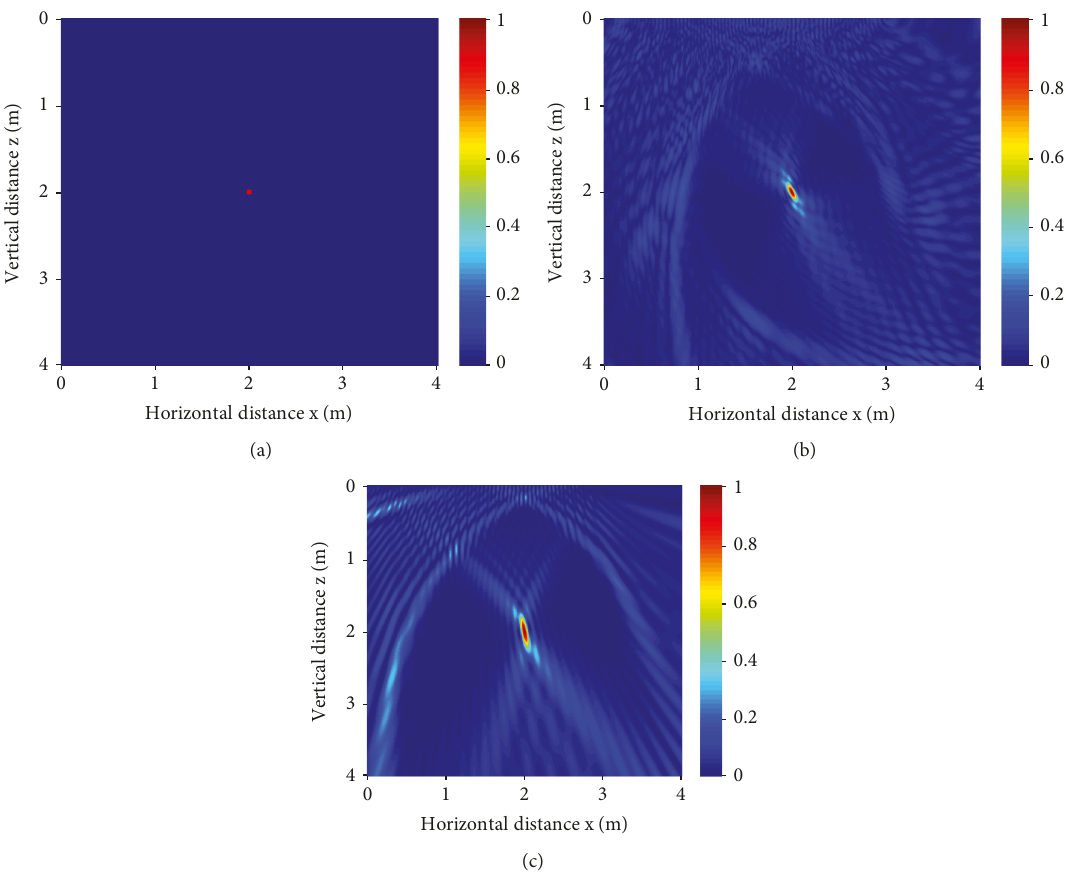
Figure 3: Single target detection: (a) actual position of target, (b) FDA-MIMO radar, and (c) conventional MIMO